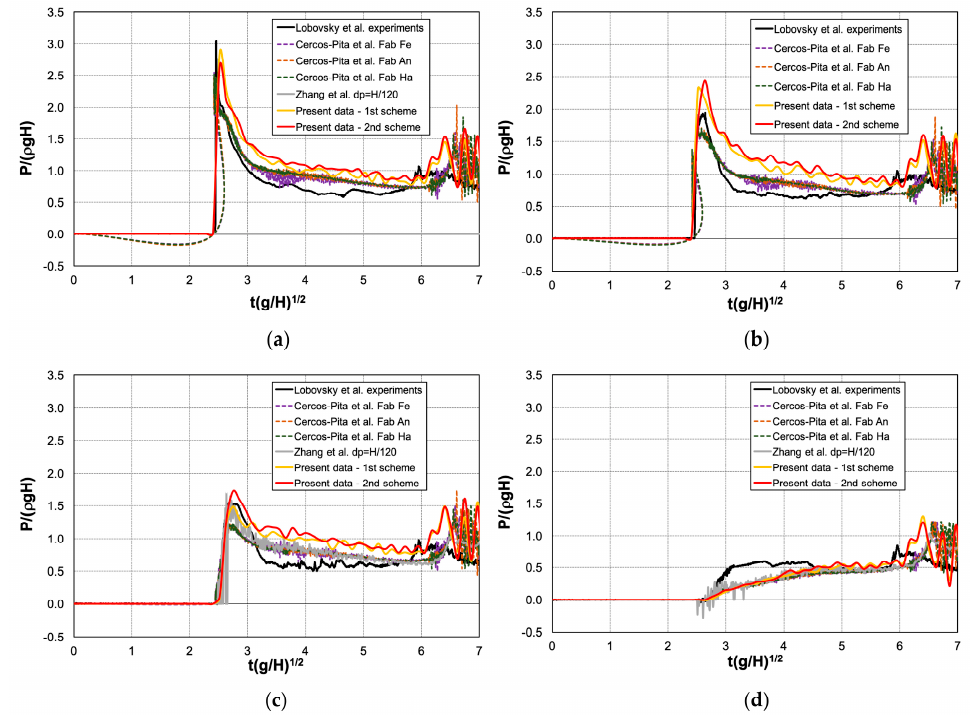
Figure 6. Temporal evolution of pressure simulated at: ( a ) P1 ; ( b ) P2 ; ( c ) P3 ; and ( d ) P4 located on the downstream vertical wall of the channel. Comparison between experimental and numerical data in the literature.